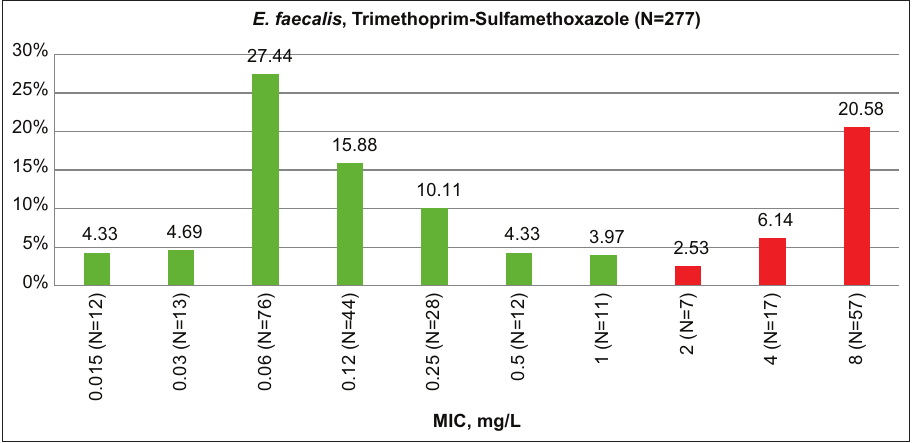
Figure-1: Trimethoprim-sulfamethoxazole minimum inhibitory concentration distribution among Enterococcus faecalis isolates. Green columns – percent of susceptible isolates, red – resistant (EUCAST 2021 breakpoints), N – number of